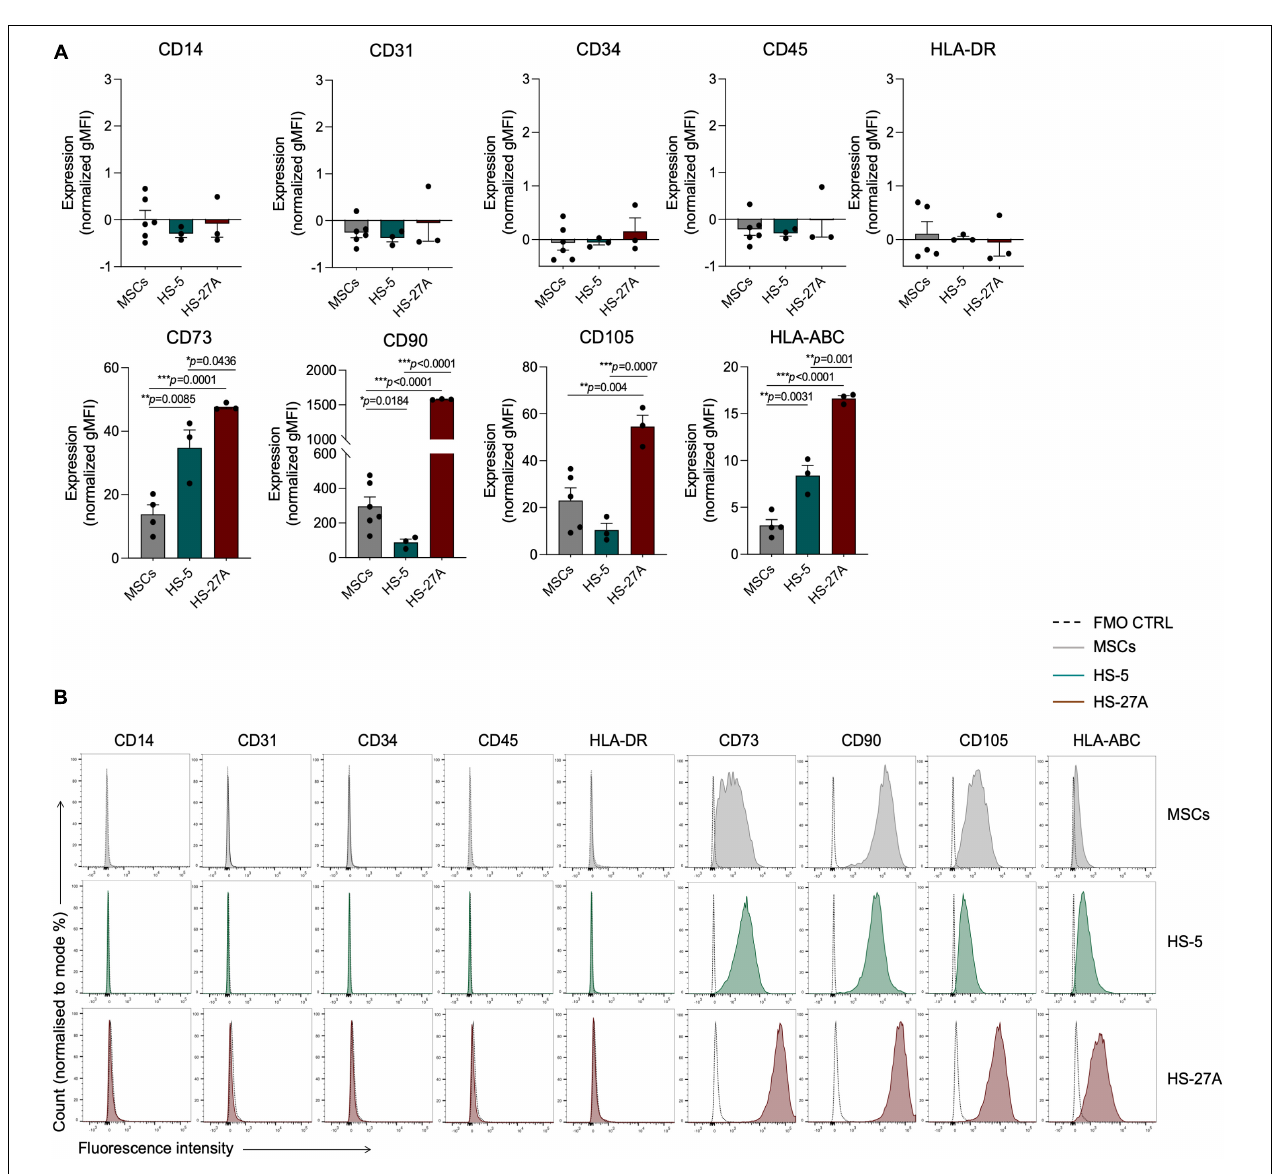
FIGURE 1 | Markers expression profile of primary MSCs, HS-5, and HS-27A cell lines. (A) Flow cytometry immunophenotypic analysis of primary MSCs, HS-5, and HS-27A cell lines showing the expression profile of specific hematopoietic markers (CD14, CD31, CD34, CD45), mesenchymal stromal cell markers (CD73, CD90, CD105), and MHC class I and II molecules (HLA-ABC and HLA-DR, respectively). Data are represented as mean of gMFI (geometric mean fluorescence intensity) normalized on FMO (fluorescence minus one) control ± SEM. (B) Representative histograms showing the expression profile of hematopoietic markers (CD14, CD31, CD34, CD45), mesenchymal stromal cell markers (CD73, CD90, CD105), and MHC class I and II molecules (HLA-ABC and HLA-DR, respectively) on MSCs, HS-5 and HS-27A cell lines.